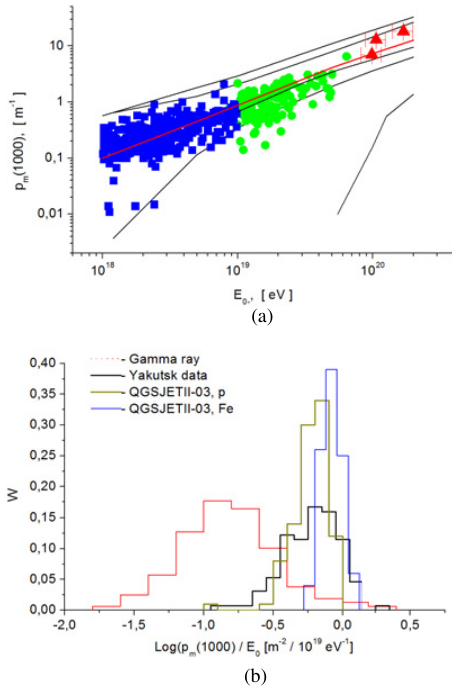
Figure 3. (a) Energy dependency of ρ µ (1000) for observed events with energy 10 18 –10 19 eV (squares) and 10 19 –10 20 eV (triangles). Expected ± 1 σ bounds of the distributions are indicated for proton, iron and gamma ray by different curves. (b) Fluctuations of ρ µ (1000)/10 19 value (eV) in showers with E 0 > 10 19 eV compared to simulation results (QGSjetII-03 + UrQMD) for protons, iron and photons.